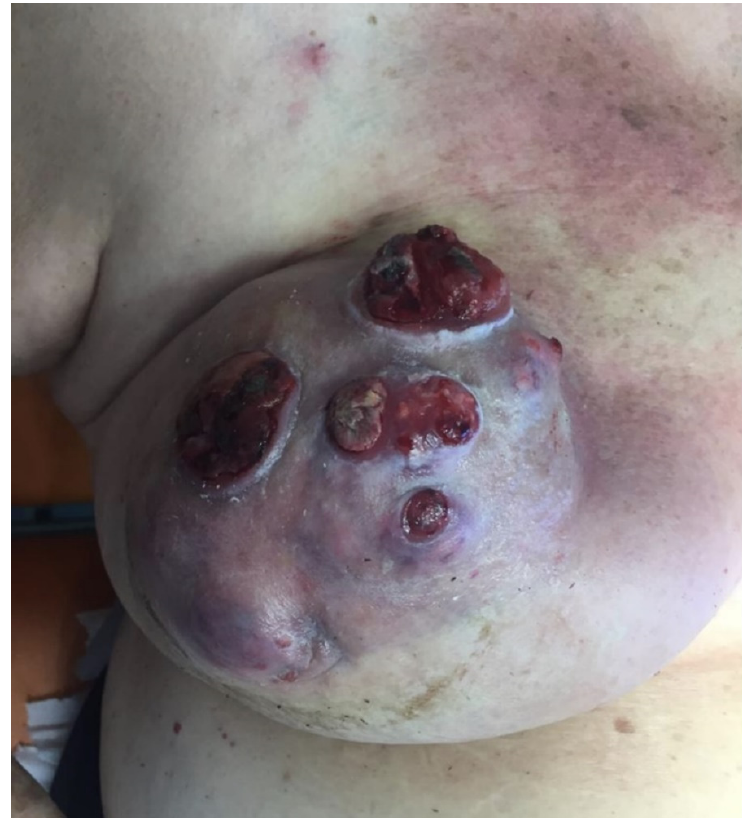
Figure 5. After 14 days.